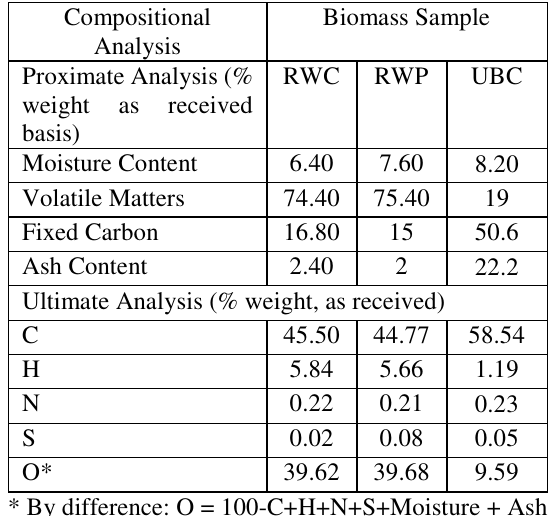
Table 1: Composition of RWC, RWP and